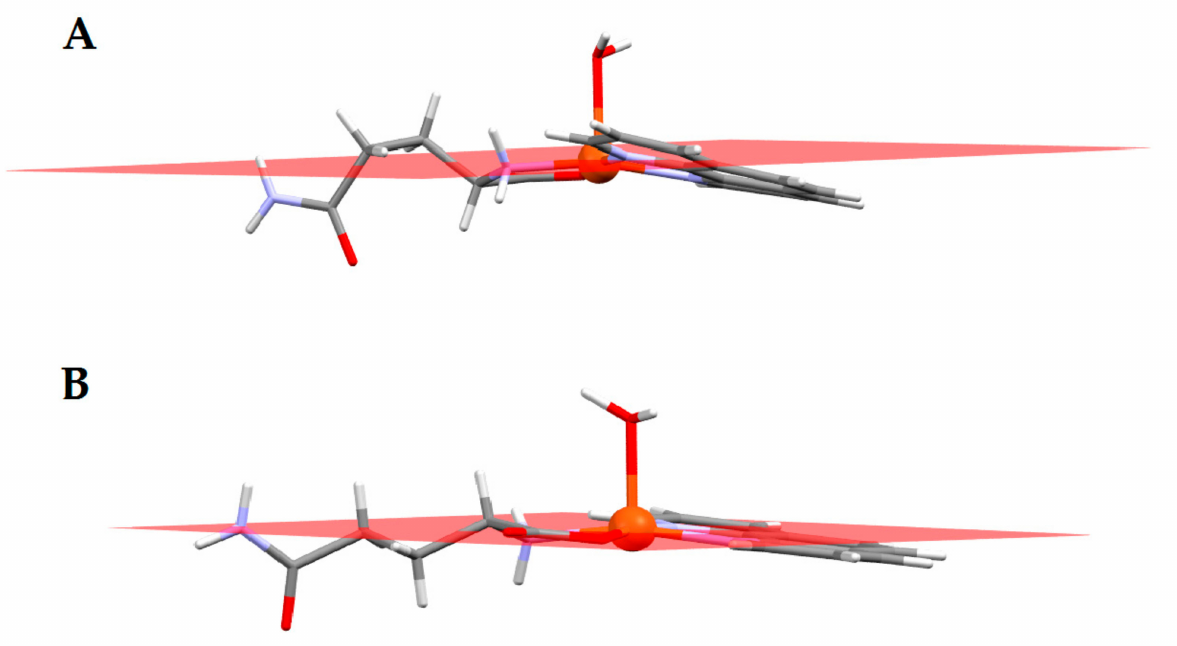
Figure 3. ( A ) anti-conformer and ( B ) syn-conformer of [Cu(L-Gln)(phen)(H 2 O] +